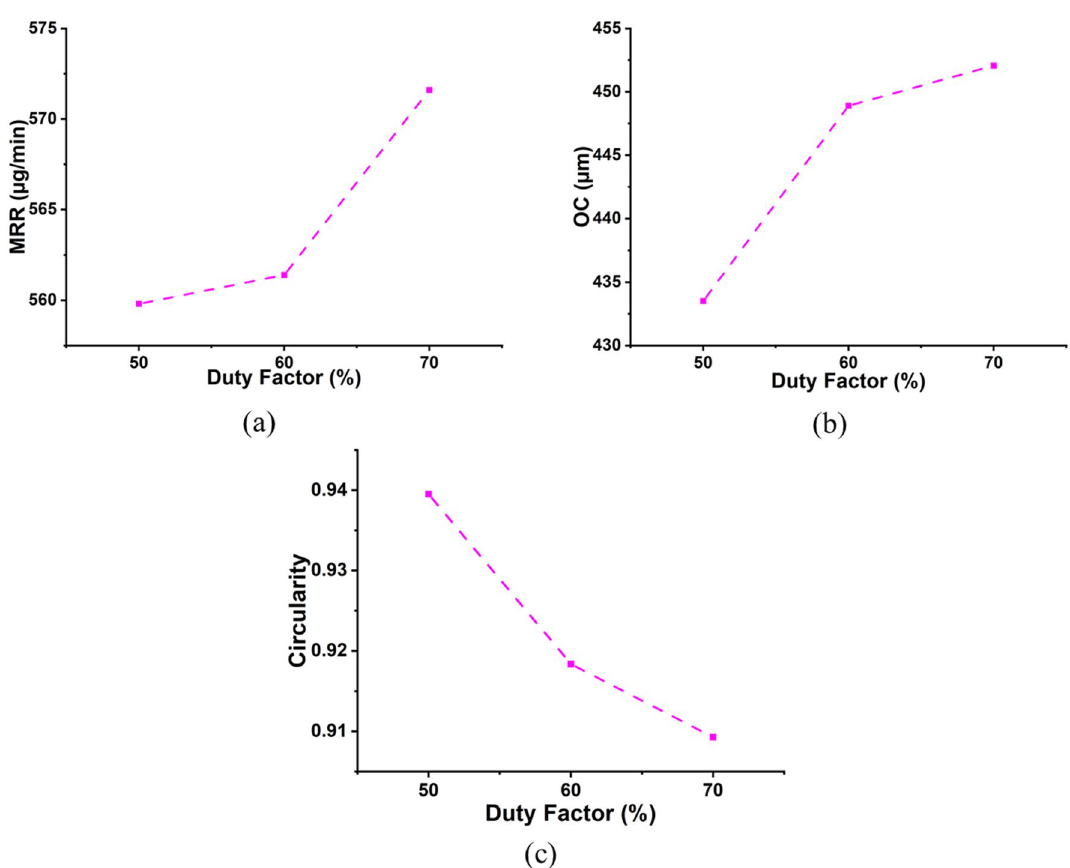
Figure 10. Influence of duty factor on machining characteristics ( a ) MRR, ( b ) OC, and ( c )